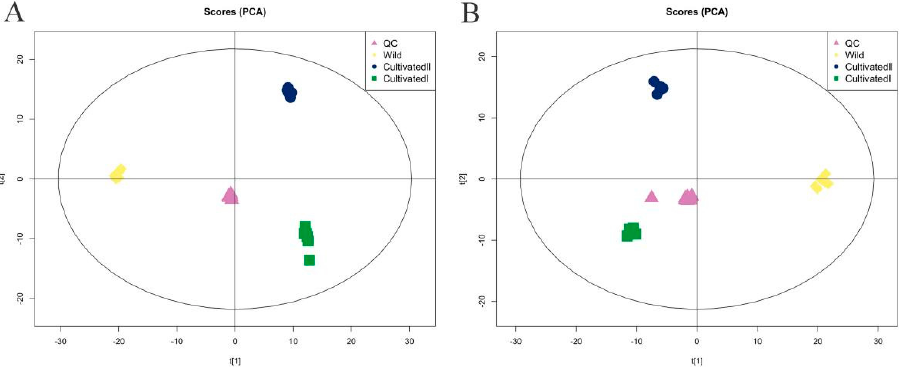
Figure 2. PCA score plot of YCH from different sources. ( A ) Pos mode; ( B ) neg mode.